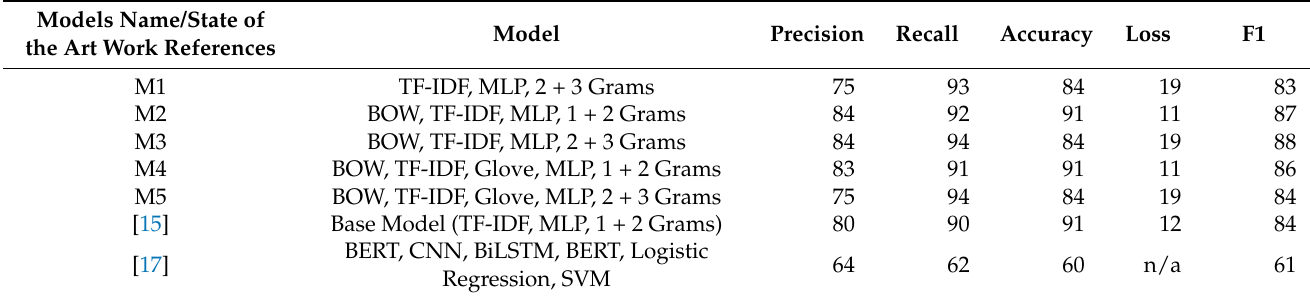
Table 4. F1 Score Proposed Models vs. State of the Art